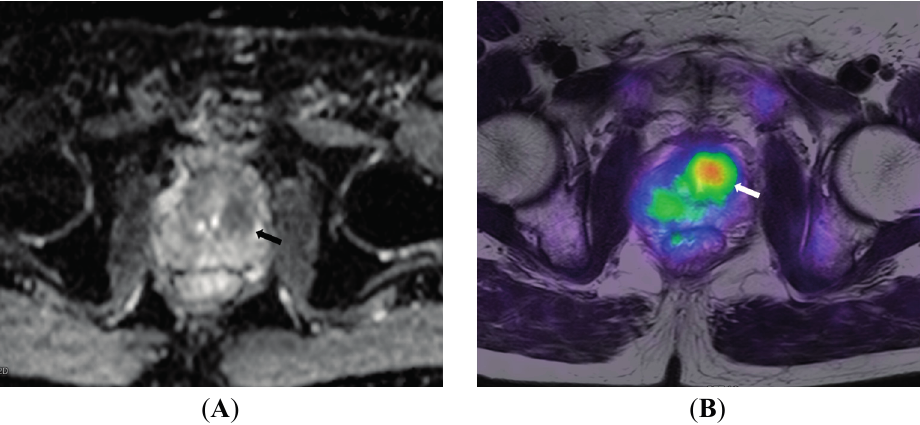
Figure 4. A 72-year old patient with prostate cancer. ( A ) ADC map shows low signal intensity in the central gland (arrow), which is confirmed by 18F-choline PET/MRI (arrow in B ) to be metabolically active central gland